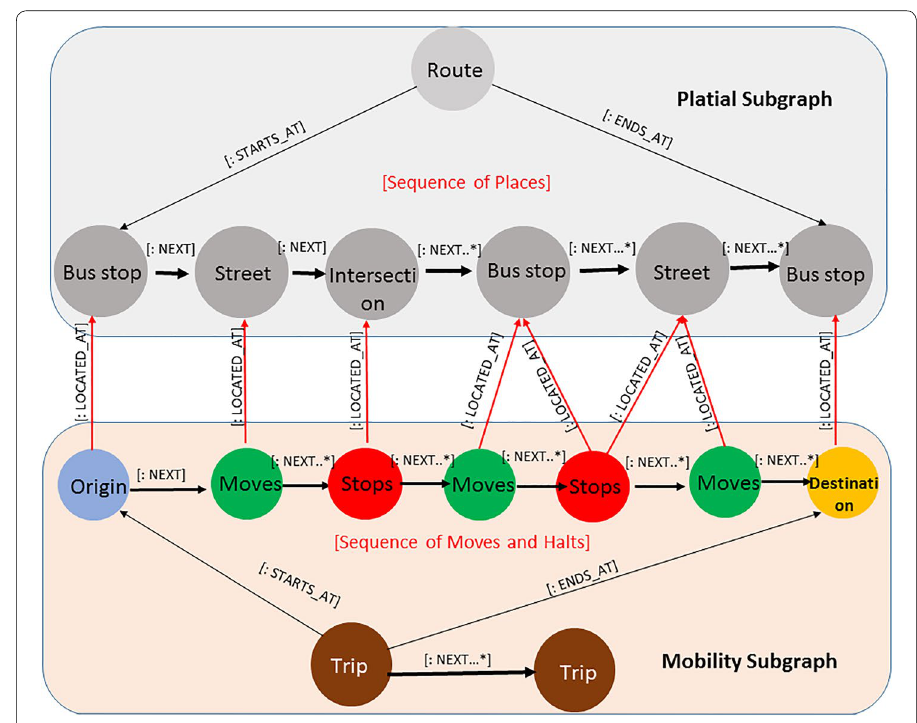
Fig. 5 The connectivity between the subgraphs